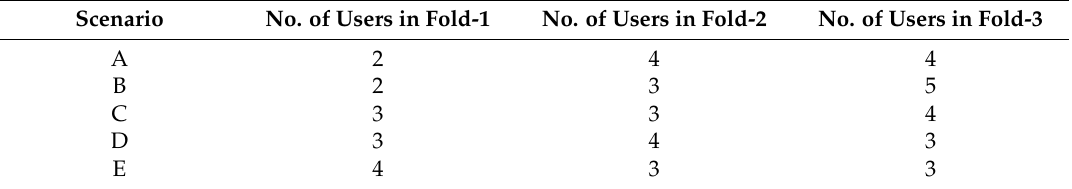
Table 7. Distribution of different users amongst three folds for user